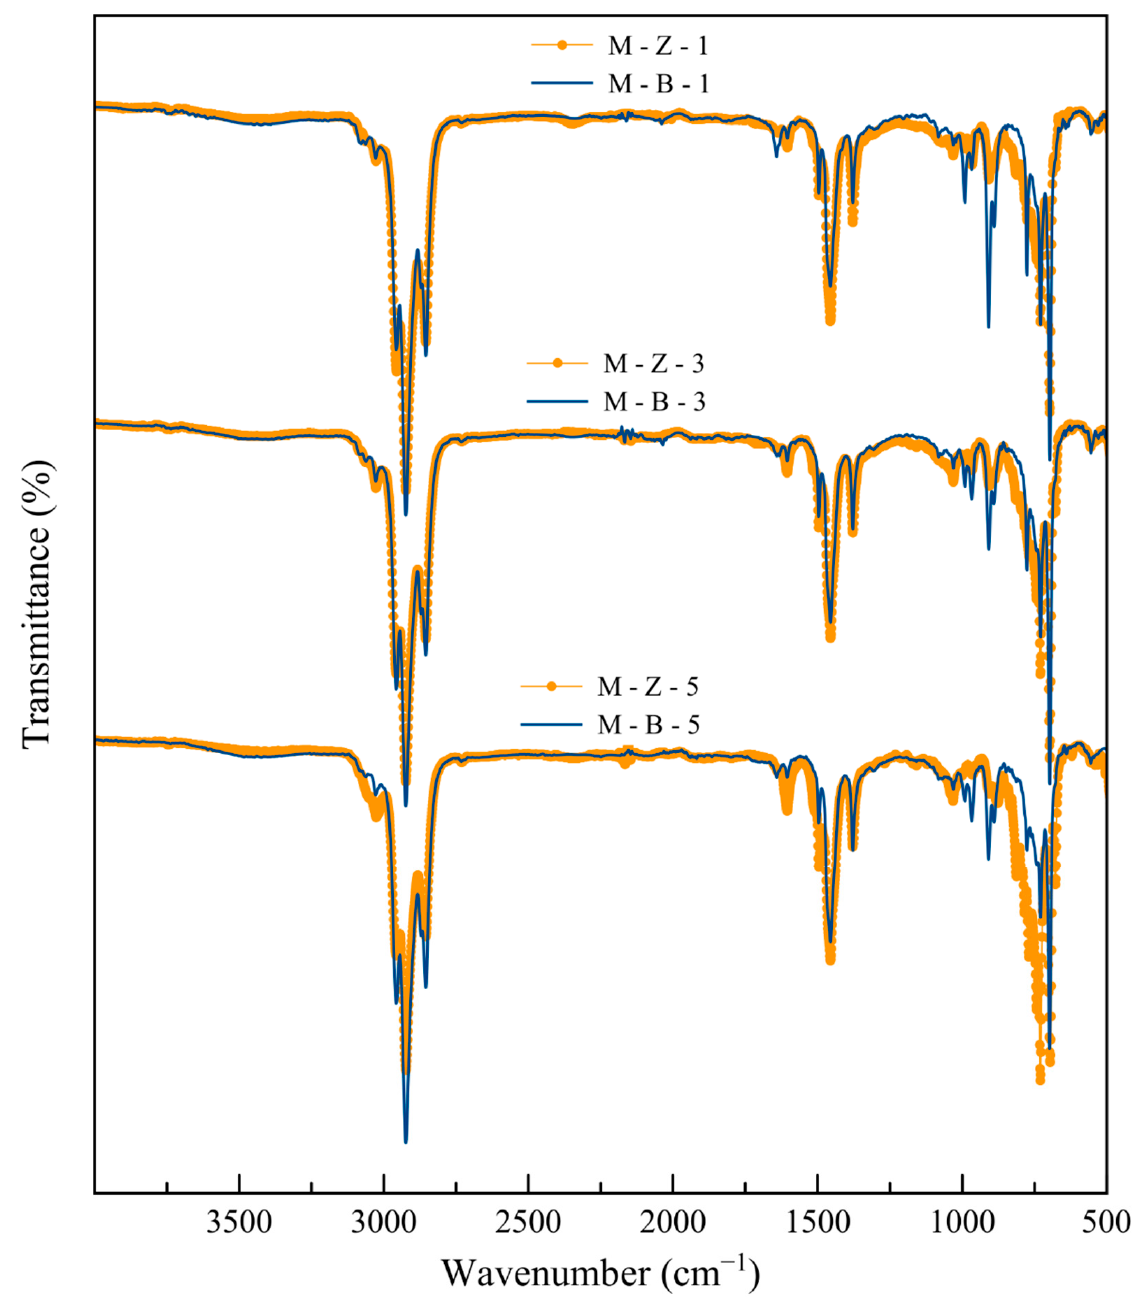
Figure 7. FTIR spectra of catalytic pyrolysis oil using zeolite and bentonite.